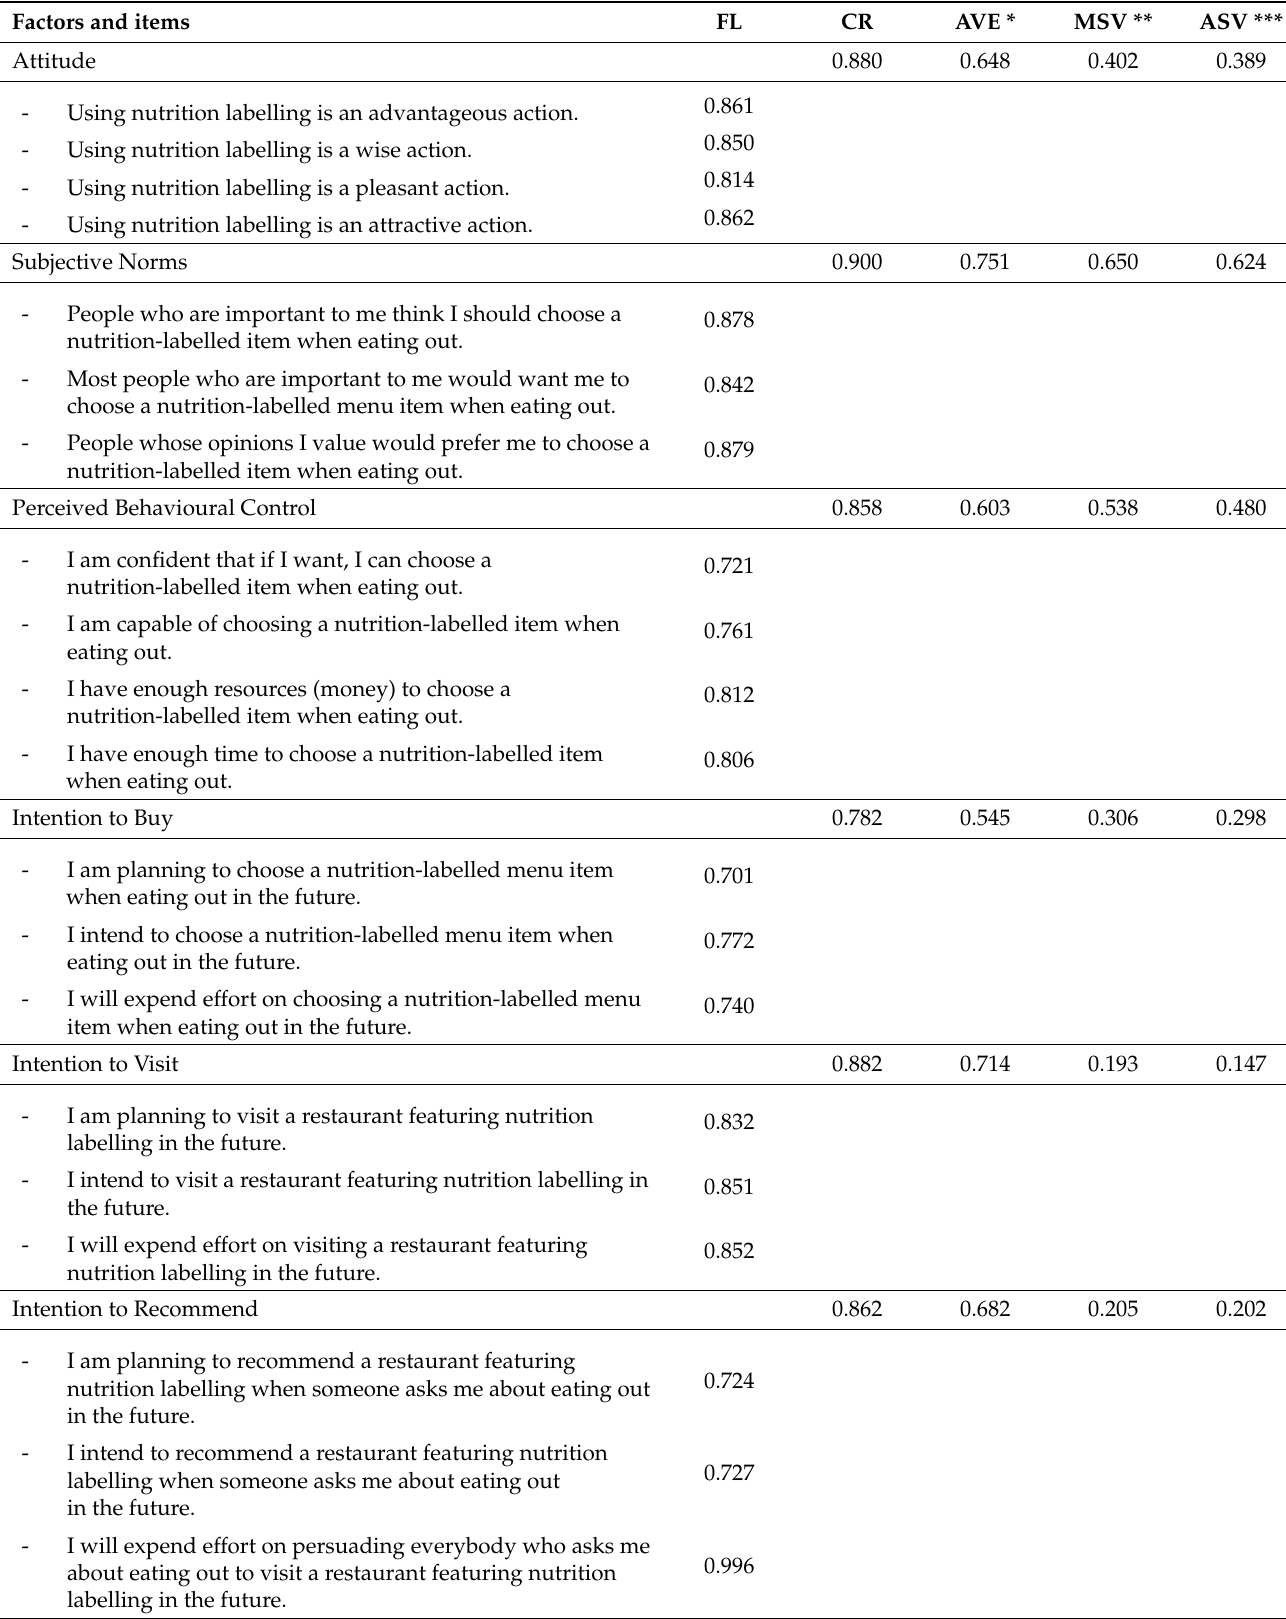
Table 3. The convergent validity